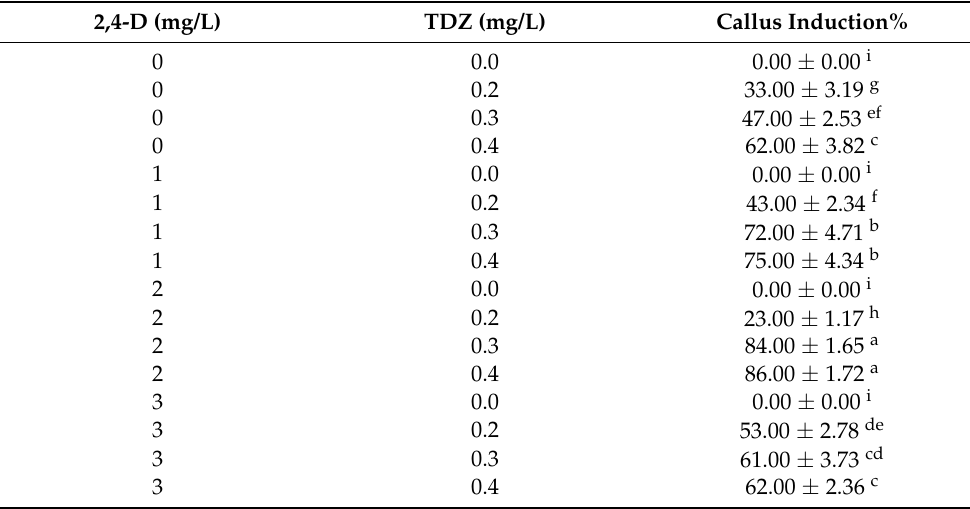
Table 2. Interaction effects of 2,4-D and TDZ concentrations on callus induction (%) of the fever- few